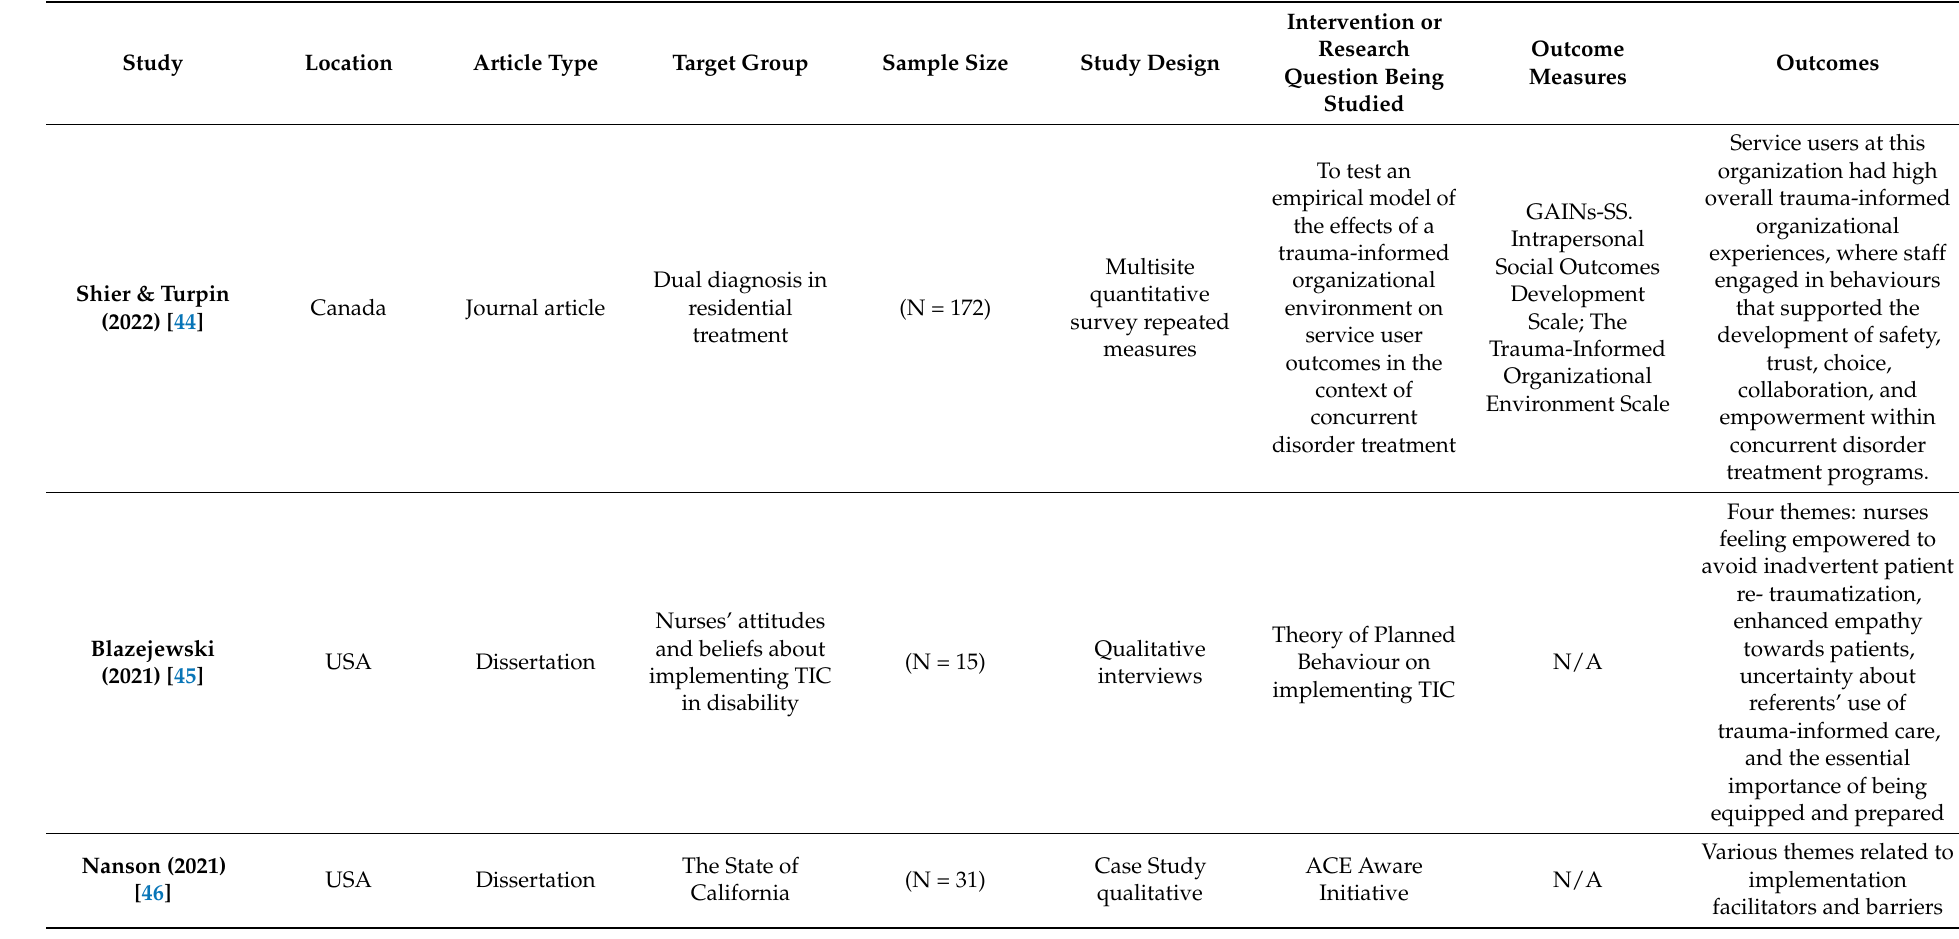
Table 2. Charted data illustrating the headings data were extracted